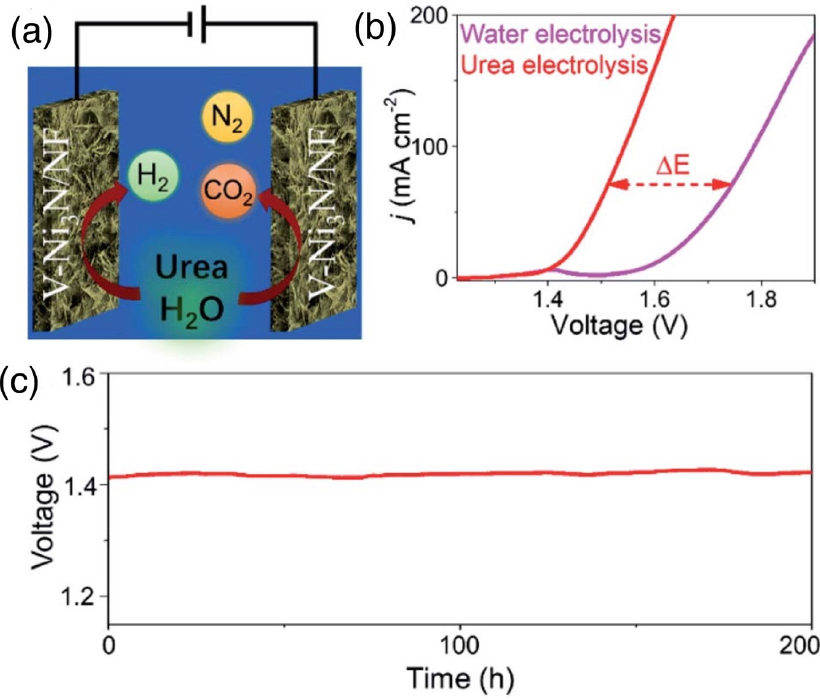
Figure 26. ( a ) Schematic illustration of the urea electrolyzer using V-NiN/NF HER and UOR. ( b ) Polarization curves of V-Ni 3 N/NF for urea and water electrolysis. ( c ) Long-term stability test performed at 10 mA cm − 2 . Reprinted with permission from Ref. [113].